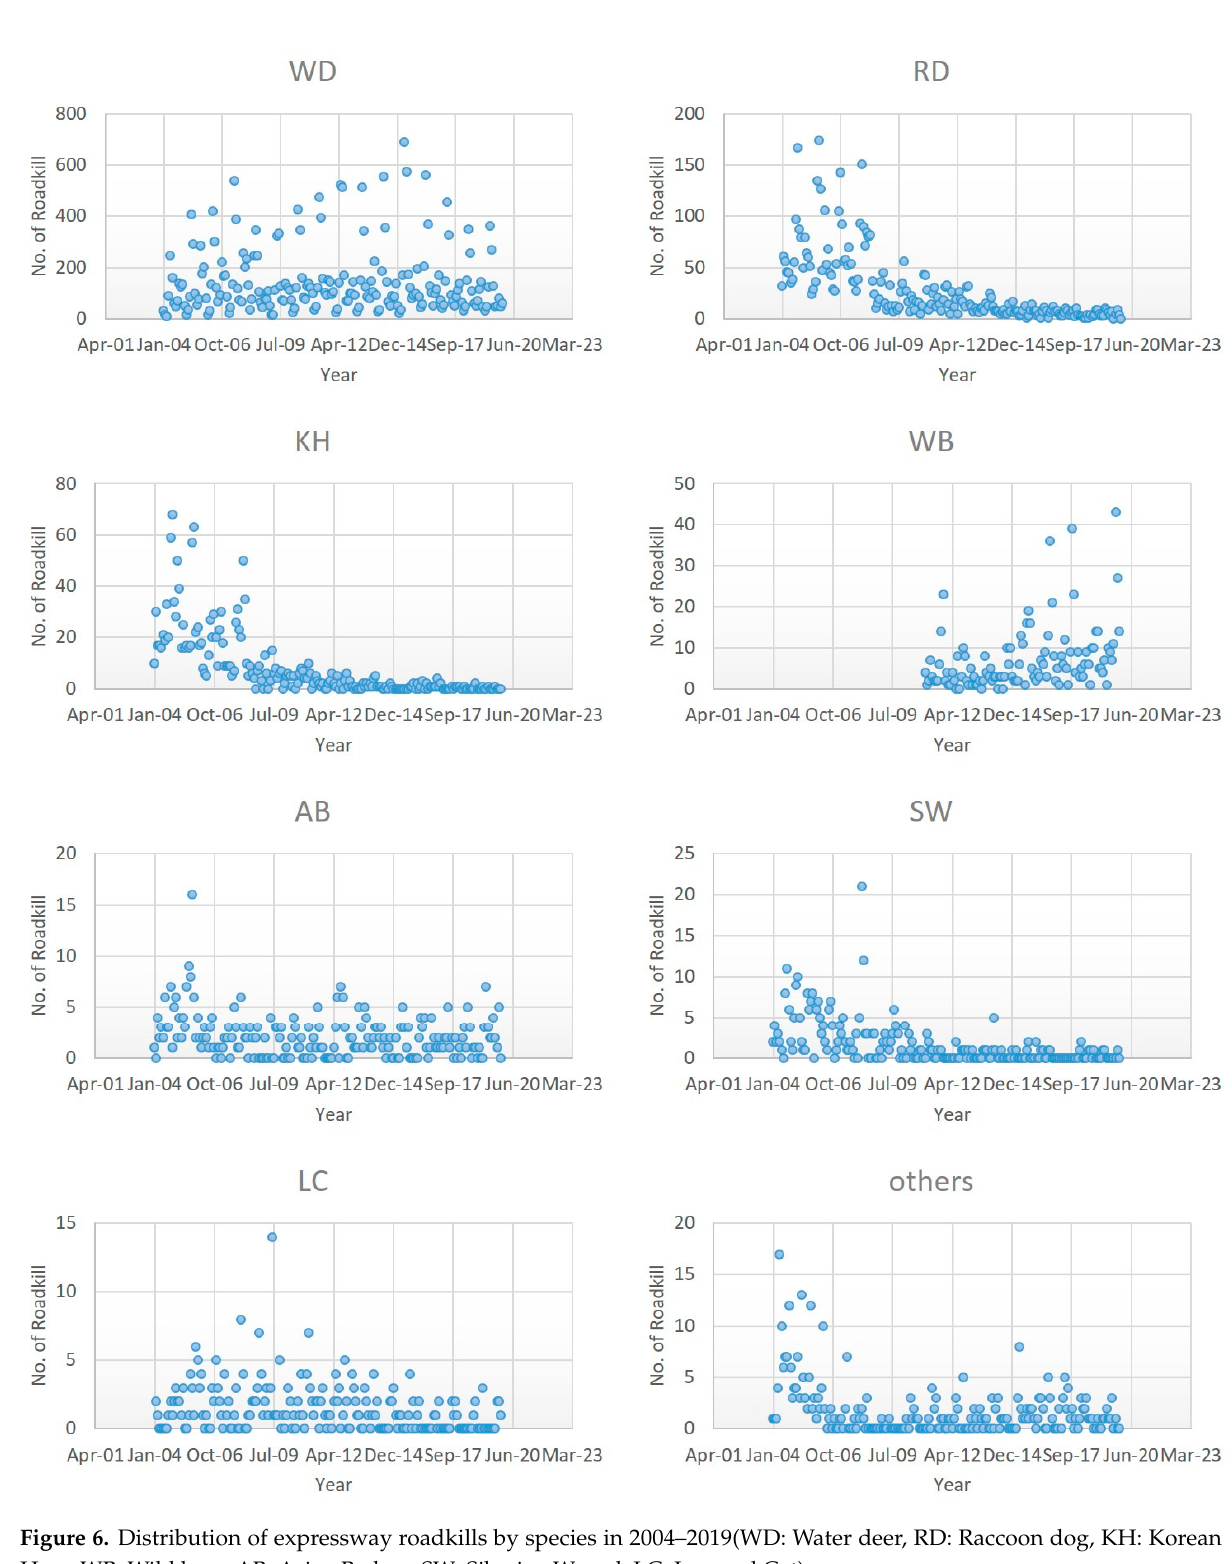
Figure 6. Distribution of expressway roadkills by species in 2004–2019(WD: Water deer, RD: Raccoon dog, KH: Korean Hare, WB: Wild boar, AB: Asian Badger, SW: Siberian Weasel, LC: Leopard Cat).